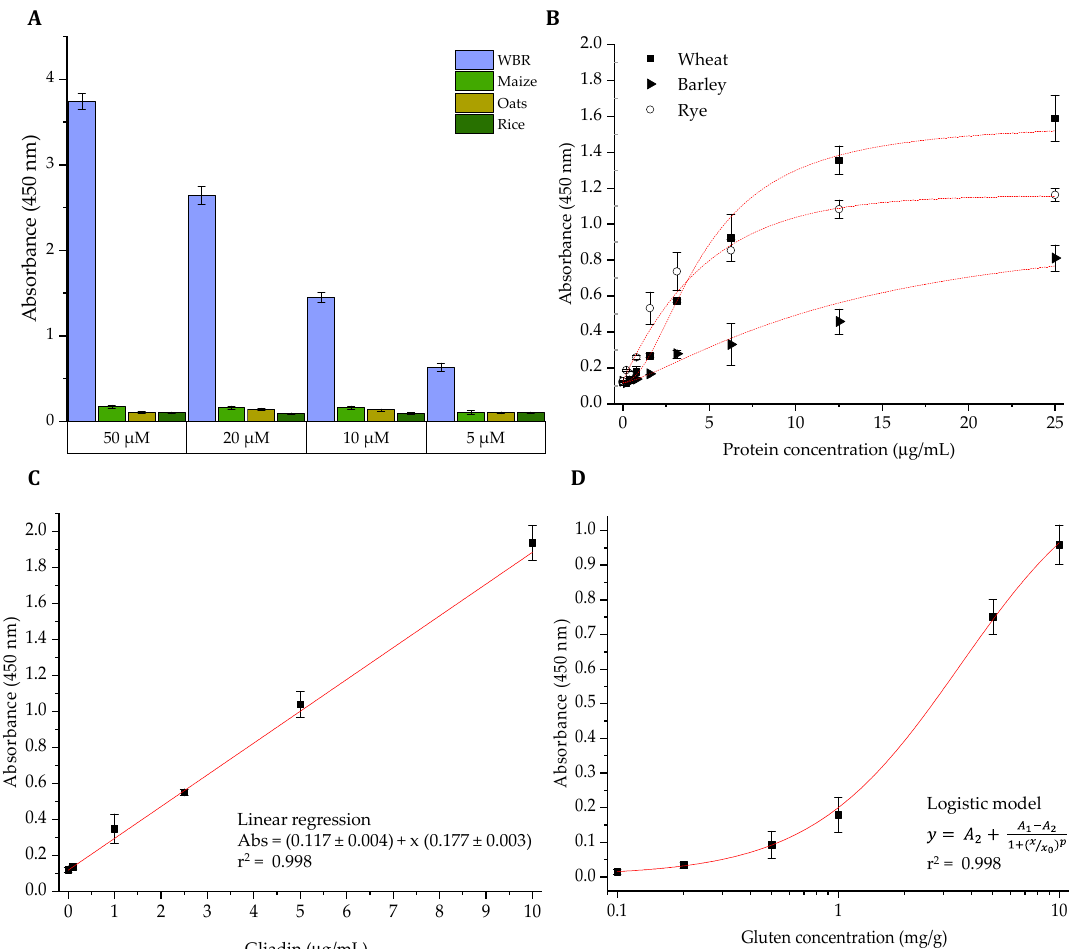
Figure 4. Assessment of a immunoassay techniques based on the purified dAb8E ( A ) Comparison of dAb8E binding by indirect ELISA to extracts WBRm, maize, oats and rice at the specified antibody concentrations (WBRm stands for a representative mixture of a wheat, barley and rye kernels) ( B ) Sandwich ELISA (soluble dAb8E and phage-dAb8E as the capture and detection antibodies, respectively) for the analysis of individual reference mixtures (40 wheats, 10 barleys and 10 ryes) at different protein concentration levels (0.1 to 25 µg/mL) ( C ) Linear regression obtained from the absorbance values of the analysis of 0.1–10 µg/mL PWG-gliadin by dAb8E-based sandwich ELISA. ( D ) Four-parameter logistic curve obtained from the analysis of binary mixtures consisting of rice flour experimentally spiked with decreasing amounts of WBRm (0.1–10 mg/g by dAb8E-based sandwich ELISA. This model was used to interpret the gluten content of the tested commercial food products. These fitting models have been obtained with Origin 8.0 software and represents the average values and standard deviations of one representative experiment performed in triplicate.